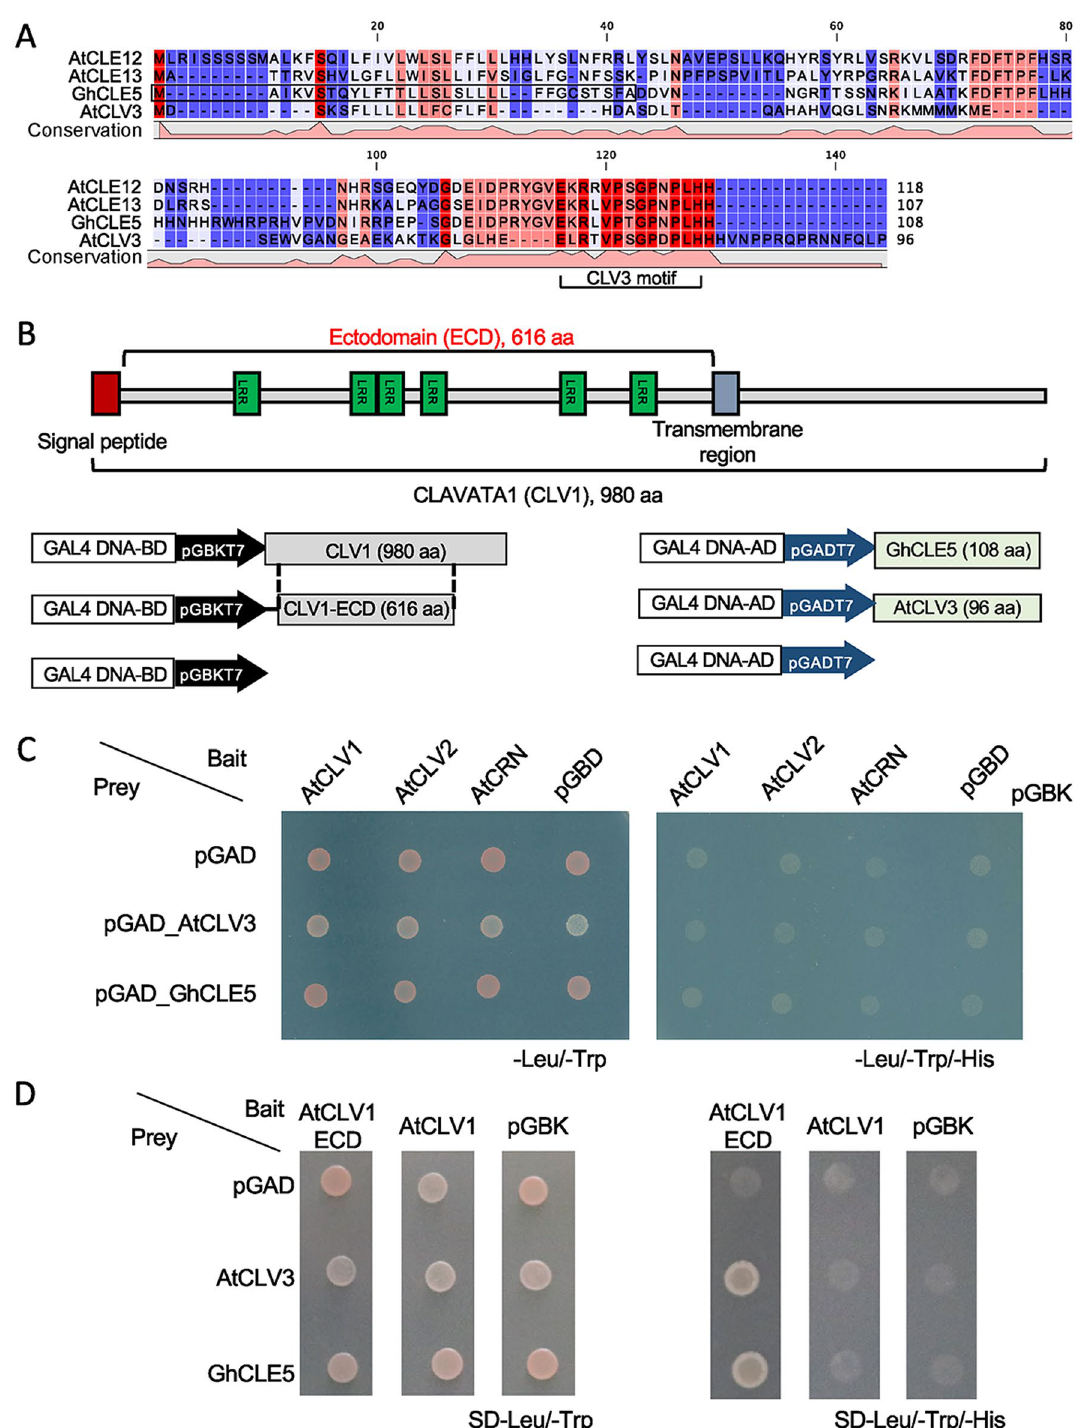
Figure 5. The interaction between AtCLV1, AtCLV3, and GhCLE5. ( A ) The amino acid sequence alignment of GhCLE5, AtCLE12, AtCLE13, and AtCLV3. The conserved CLV3 motif is indicated. The black box is the putative signal peptide (http://smart .embl-heide lberg .de/). ( B ) The schematic chart showing the protein structure of AtCLV1 and the design for the yeast two-hybrid assay. ( C ) and ( D ) Photo images for the yeast two- hybrid assay that tested the interaction between AtCLV3, GhCLE5, and